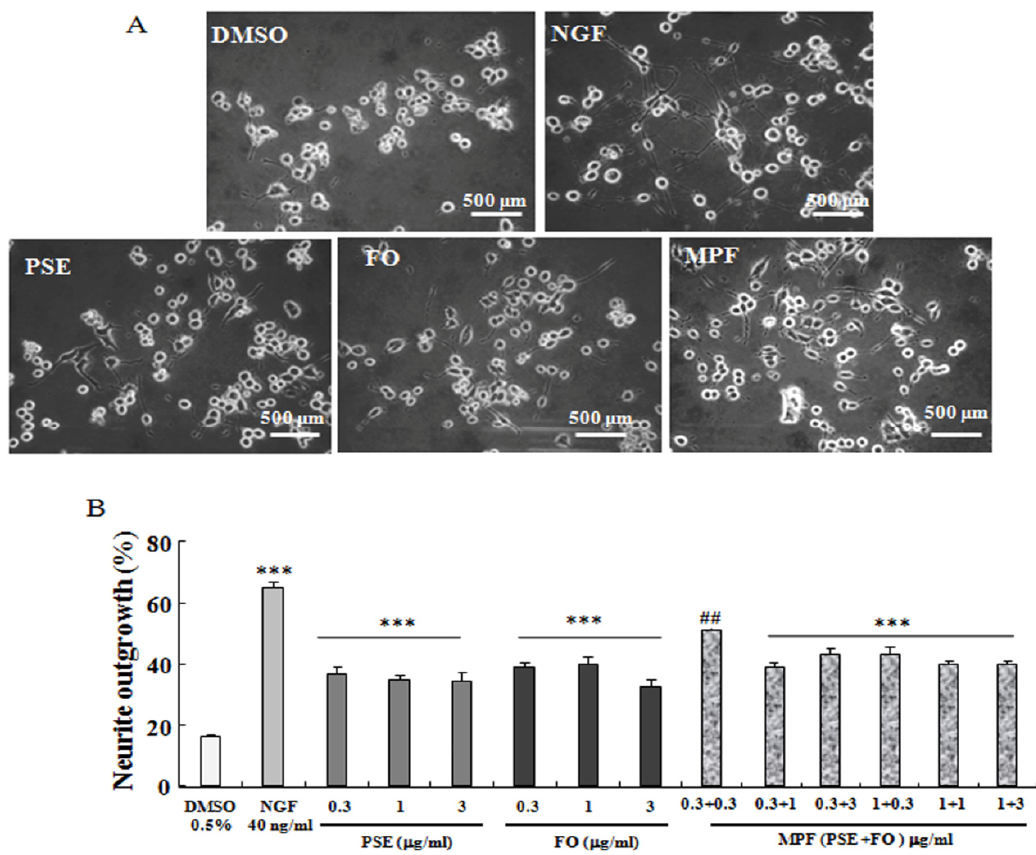
Figure 1. NGF-mimicking effects of PSE, FO and MPF on PC12 cells. ( A ) microphotograph of PC12 cells after treatment with DMSO, NGF, PSE, FO and MPF for 48 h; ( B ) percentage of PC12 cells with neurite outgrowth after treatment with DMSO, NGF, PSE, FO and MPF for 48 h. Cells bearing neurites were identified as those with processes that were at least twice the cell diameter in length. (Control: DMSO, 0.5%; Positive control: NGF, 40 ng/mL). *** Significantly different from the control group at the same time point at p < 0.001. ## Significantly different compared to only PSE or FO treated group at a dose of 0.3 µ g/mL.